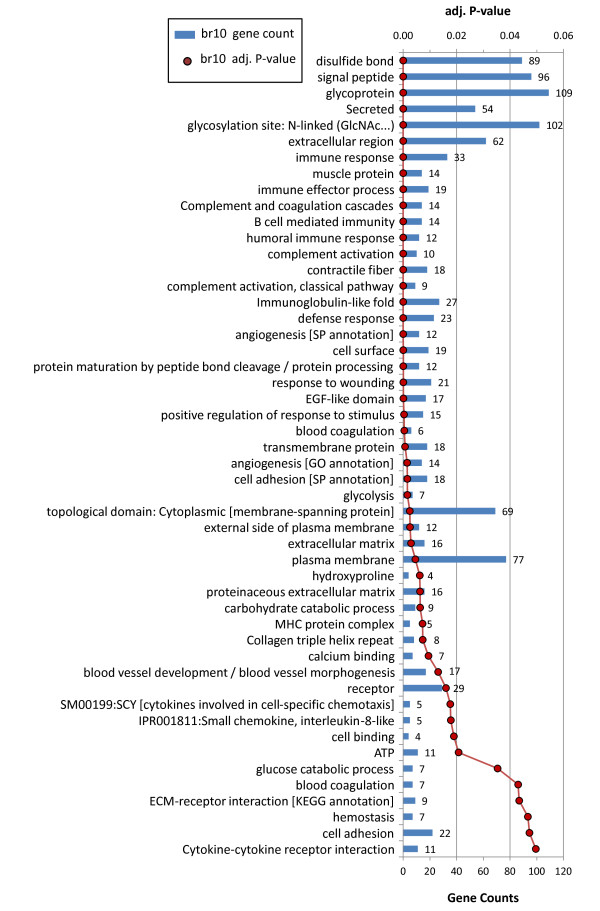
Functional groups significantly enriched among genes upregulated in Spalax brain after 10% 44hrs hypoxia (br10). Red line chart (scale on the top) shows Benjamini adjusted P-value for specific ontology terms. Blue bar (bottom scale) denotes gene counts. The listed terms were first clustered, so that similar categories are typically adjacent.